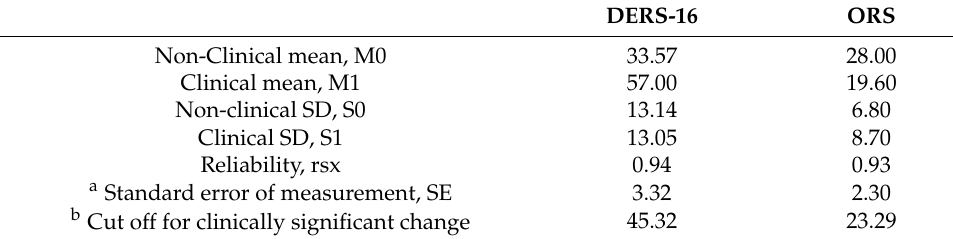
Table 3. Data used to compute reliable and clinically significant